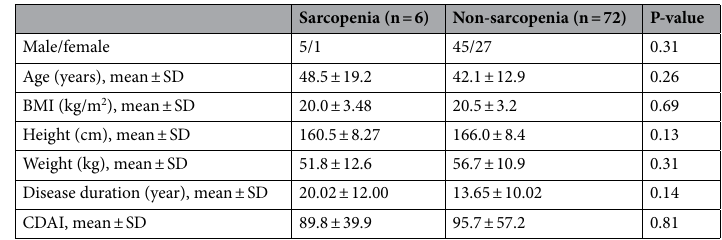
Table 2. Comparison of the sarcopenia group and non-sarcopenia group. Data were analyzed using the t test or χ 2 test. BMI body mass index, CDAI Crohn’s disease activity index, SD standard deviation.